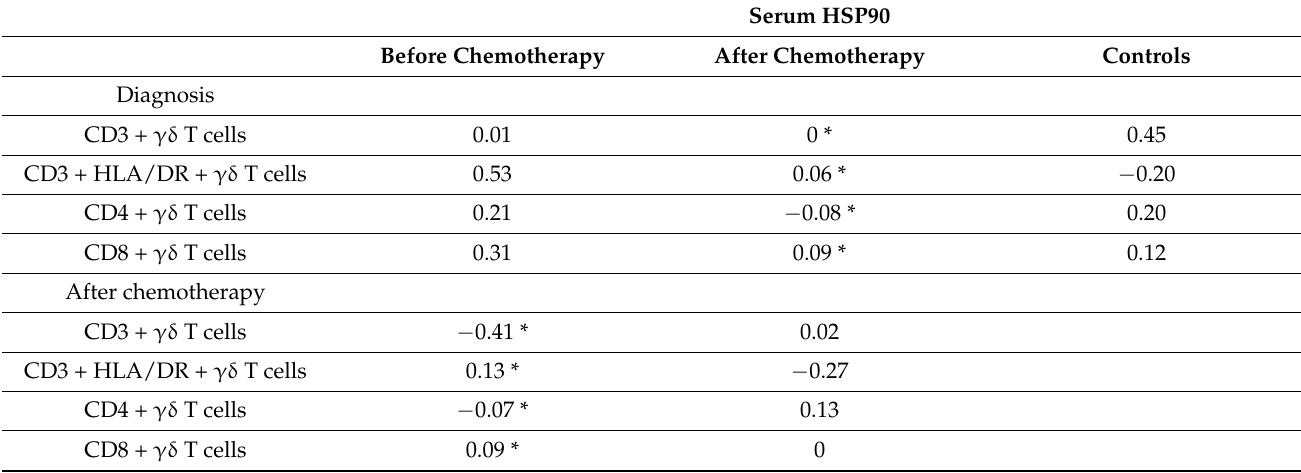
Table 2. The results of the correlation coefficient between serum HSP90 and γδ T cells in the research group and controls. Serum HSP90 Before Chemotherapy After